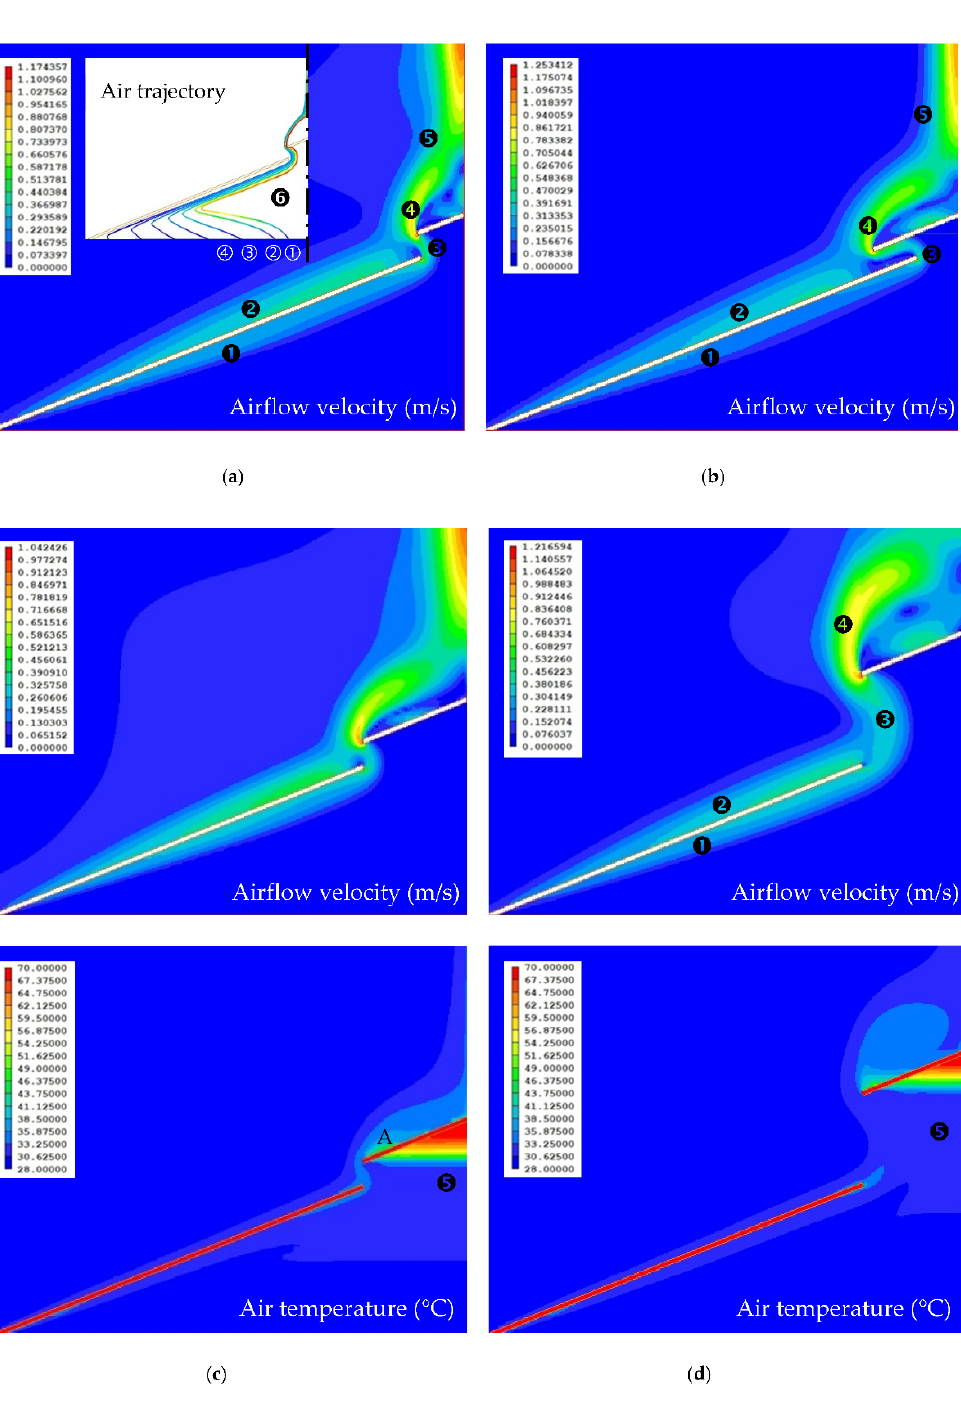
Figure 4. Distribution of flow fields and temperatures. ( a ) S = 1.2 m, H = 0.3 m, E = 0 m; ( b ) S = 1.2